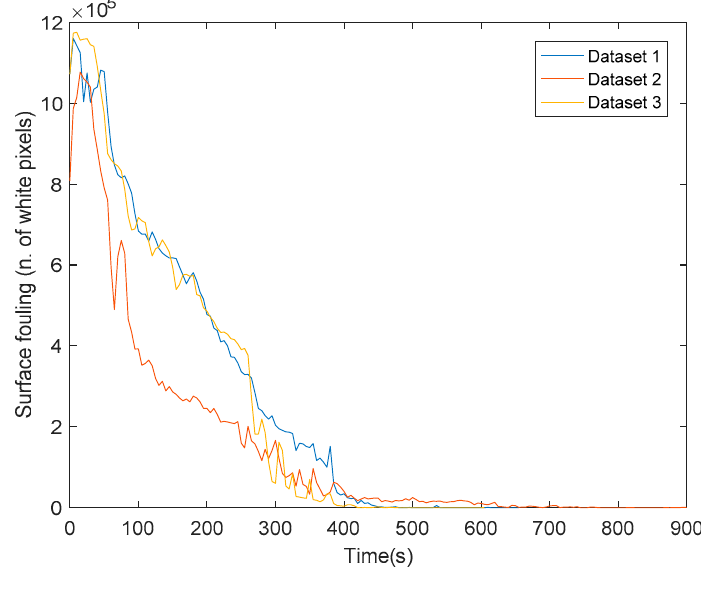
Figure 13. Surface fouling chart.